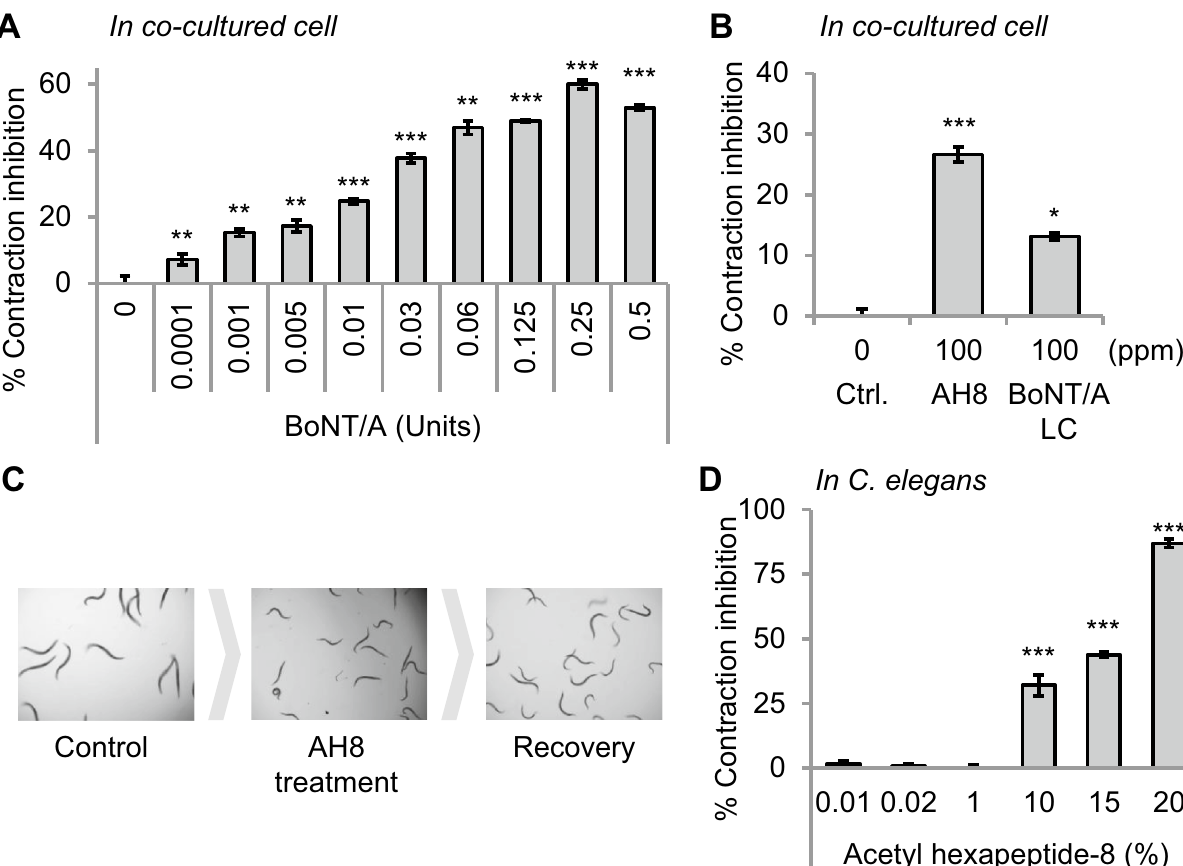
Figure 1. Muscle contraction assays in the co-cultured cell system and C. elegans system. ( A ) Validation of the muscle contraction assay in a co-cultured cell system. Botulinum toxin type A (BoNT/A) treatment inhibited muscle contraction in a dose-dependent manner. ( B ) Acetyl hexapeptide-8 (AH8) and BoNT/A light chain (BoNT/A LC), which are known as BoNT-like reagents also inhibited muscle contraction in cells. ( C ) Muscle contraction inhibition by acetyl hexapeptide-8 (AH8) treatment was reversible in C. elegans . Ten percent of acetyl hexapeptide-8 fully inhibited the movement of C. elegans , and the paralysis was completely recovered after removing chemicals by simple washing. ( D ) Acetyl hexapeptide-8 treatment inhibited muscle contraction in C. elegans as well. For the muscle contraction assays , all the experiments were performed at least twice. Error bars represent standard error of mean (S.E.M., * p < 0.05, ** p < 0.01, *** p < 0.001, two ‐ tailed Student’s t ‐